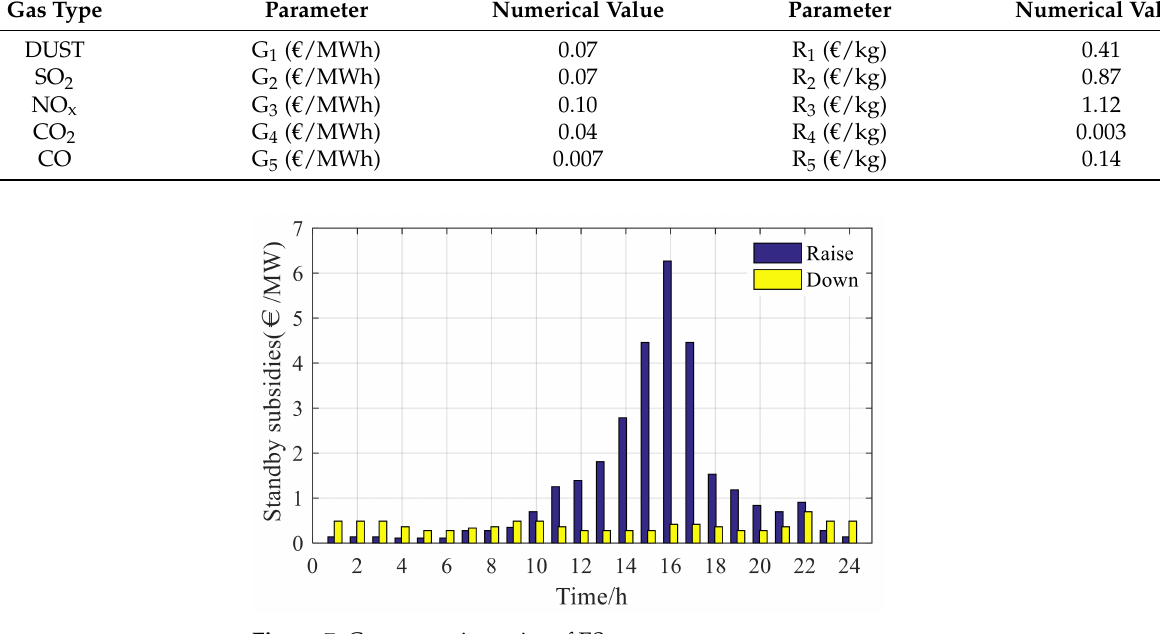
Figure 7. Compensation price of ES reserve.